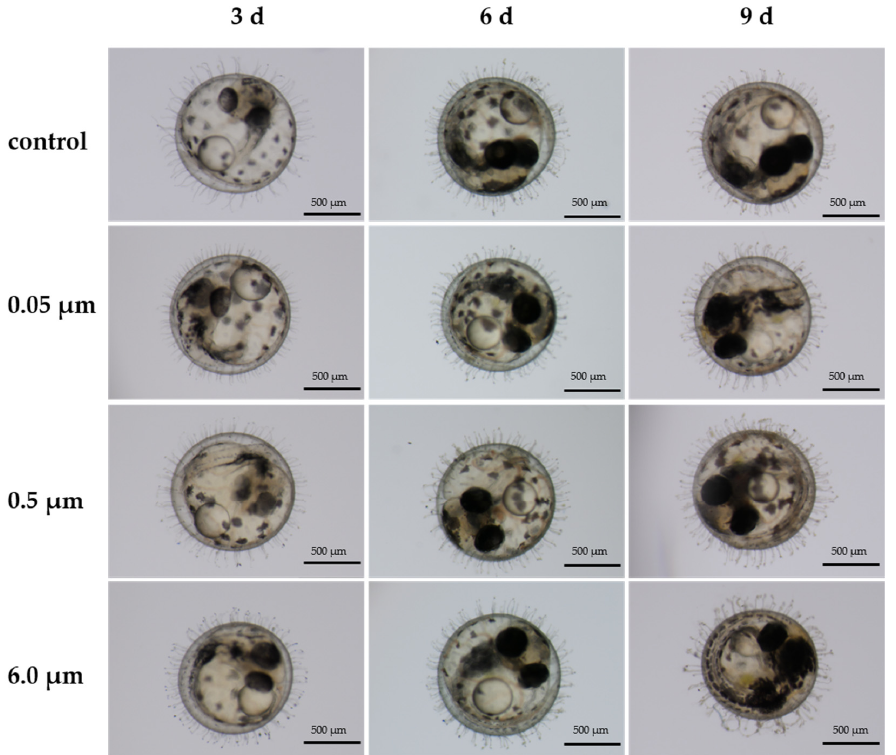
Figure A4. Effects of PS-MPs of different sizes on the chorion of O. melastigma embryos (n = 9).